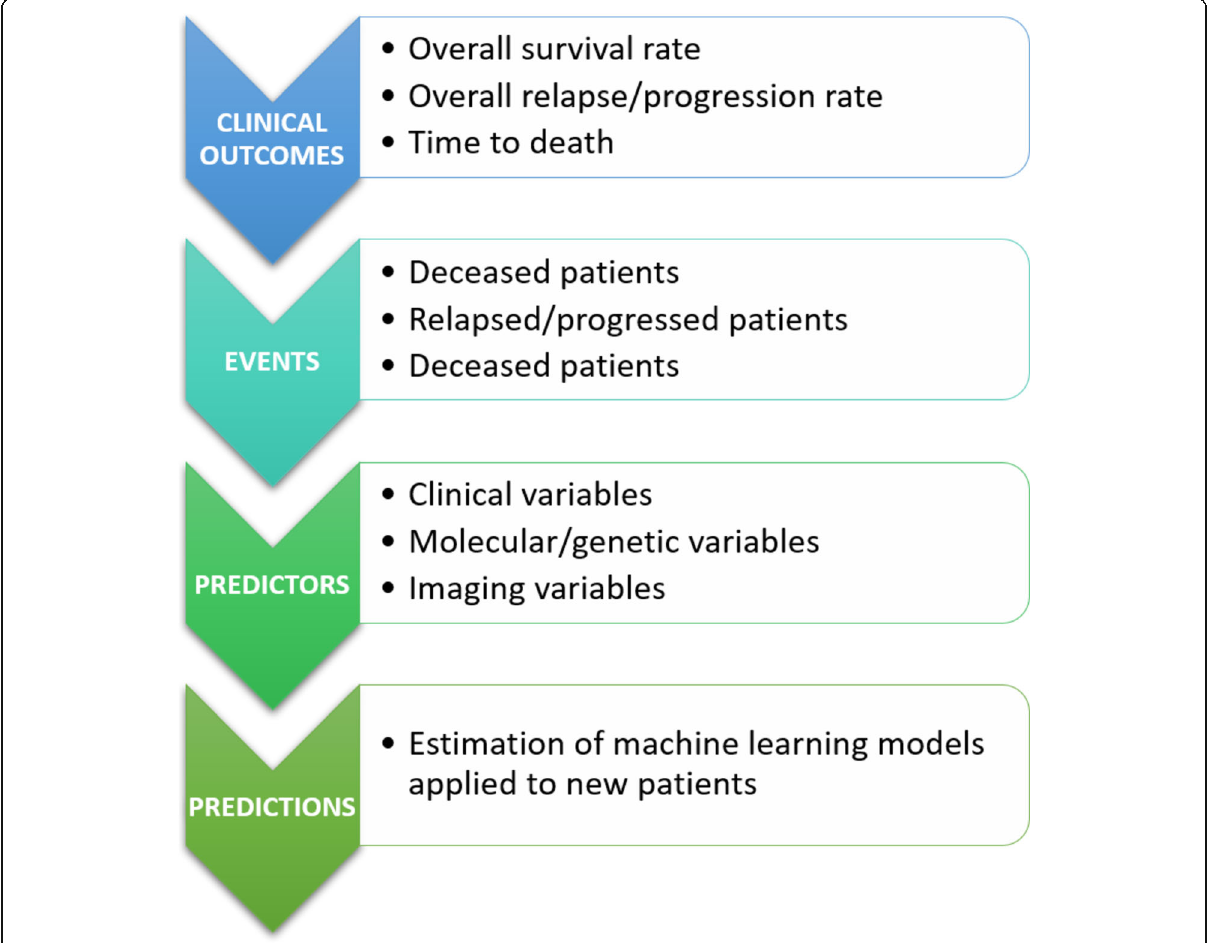
Fig. 1 Factors involved in sample size estimation and model development. Example of the clinical outcomes, events, predictors and predictions applied to